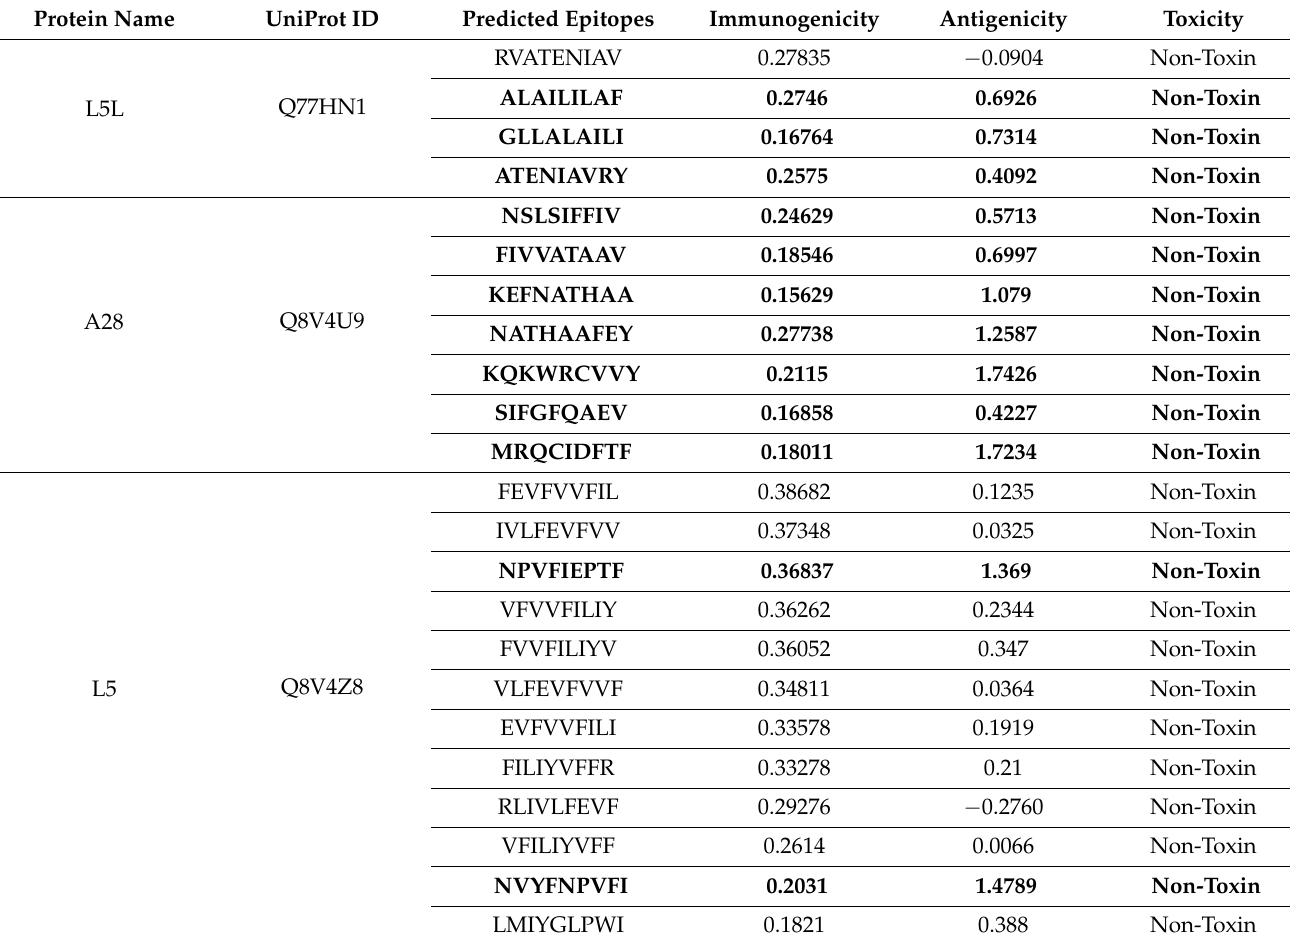
Table 2. The immunogenicity, antigenicity, and toxicity of 23 MHC class-I T-cell epitopes . High- lighted (bold) are finalized MHC class-I T-cell